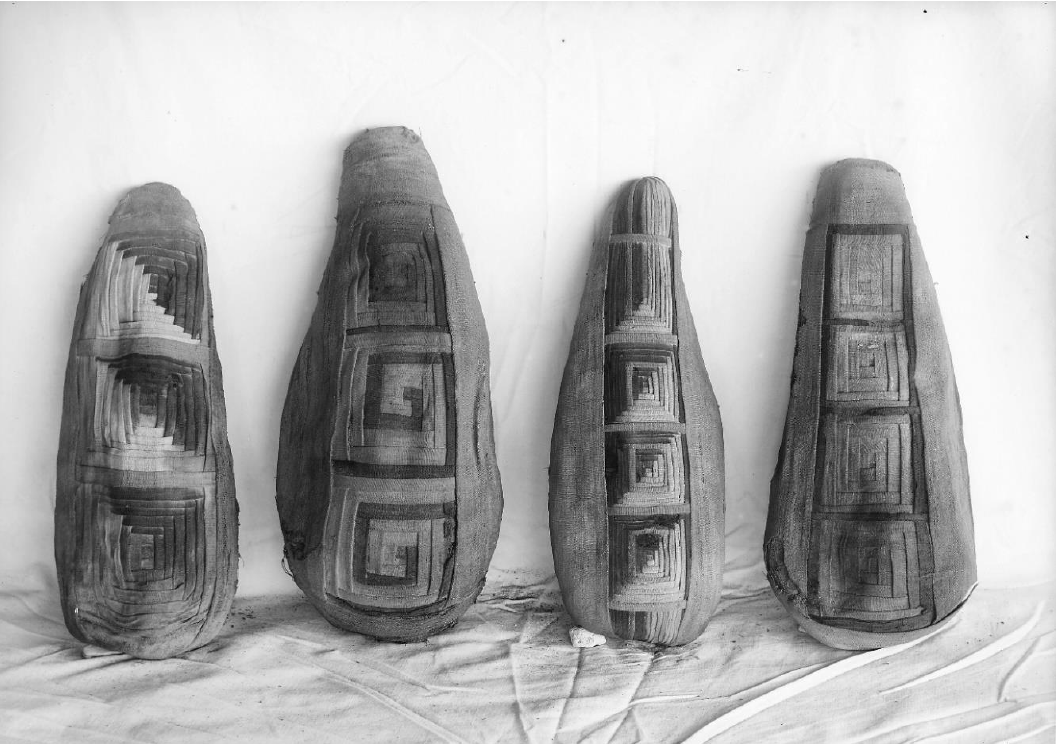
Figure 4. Post-excavation photograph showing four well-preserved and elaborately wrapped ibis mummies from Cemetery E. [Reproduced by kind permission of the Egypt Exploration Society, London.].